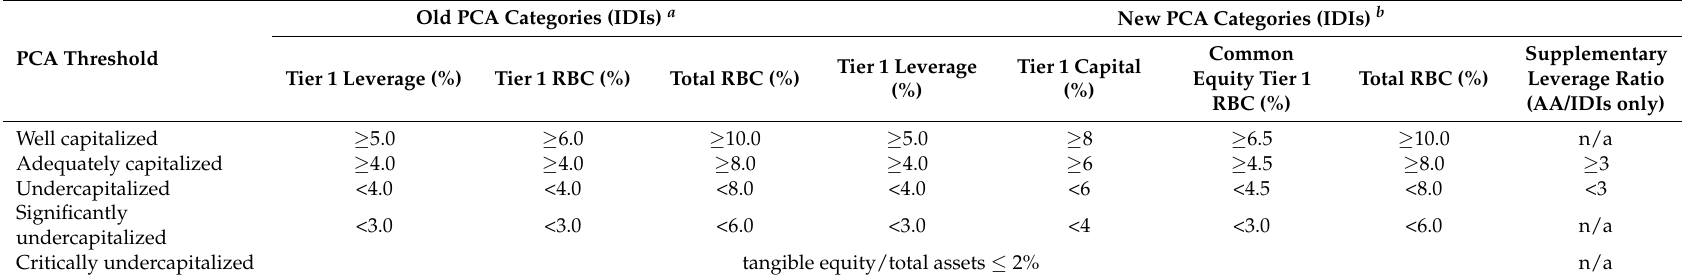
Table 6. US Prompt Corrective Action (PCA), Old and